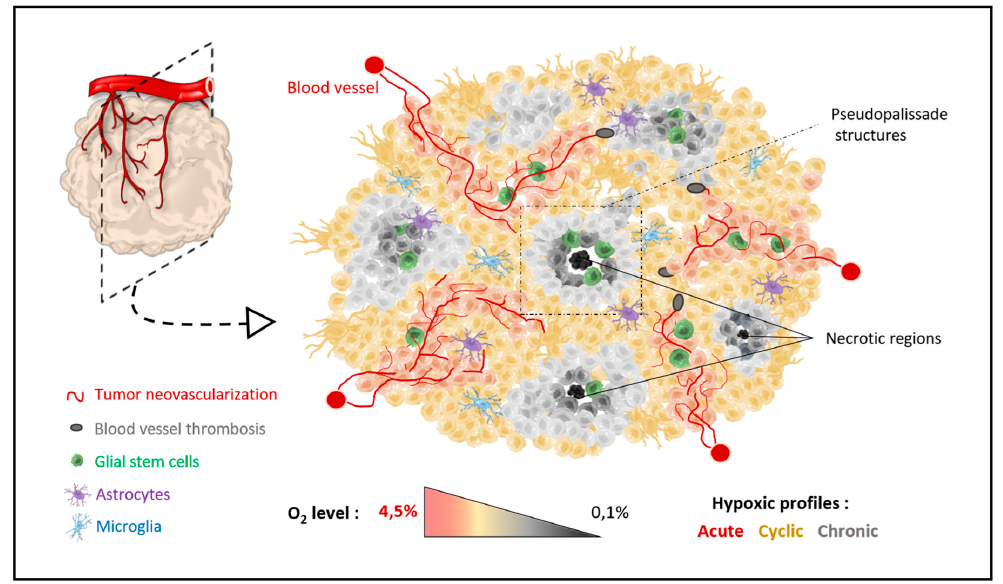
Figure 2. Organization of hypoxic regions across tumors. The pediatric high-grade gliomas are composed by necrotic regions surrounded by pseudopalissade structures and associated with stem cell niches. Neovascularization is starting from the periphery of the tumor and is decreasing in the center. Three hypoxic profiles are, then, described within pHGG tumors: acute, cyclic and/or chronic oxygen tensions.